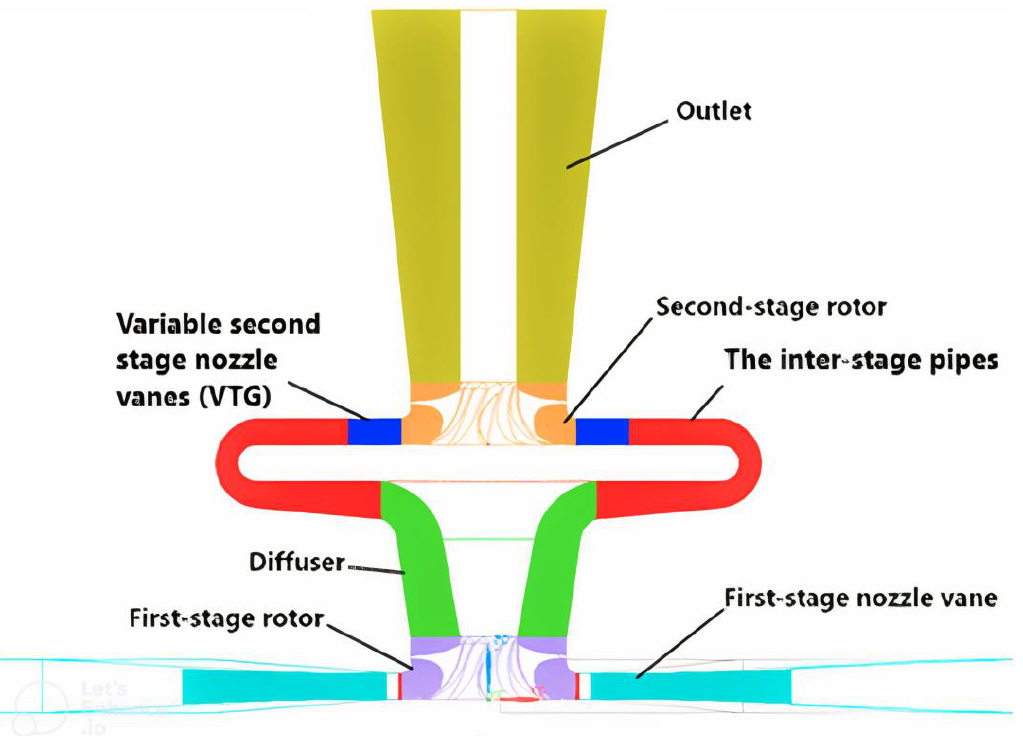
Figure 4. The cross-sectional view of the model [27].